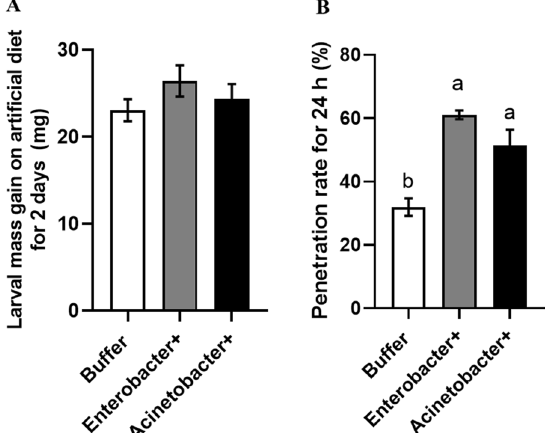
Fig. 6 Impacts of bacterial inoculation on the performance of SSB larvae. Axenically reared insects were inoculated with 2 bacterial isolates on artificial diet for 2 days and transferred to rice plants. A Growth of SSB larvae were analyzed when fed on artificial diet inoculated with Enterobacter and Acinetobacter ( F (2,100) 1.118, = P 0.3309; n 34–35). B The penetration rate of SSB larvae = = inoculated with Enterobacter and Acinetobacter within 3 days of feeding on rice plants were measured ( F (2, 6) 19.06, P 0.0025; = = n 3). Values are means SEM. Different letters above bars indicate = ± statistically significant differences between treatments based on an Fig. 7 Defensive responses of rice plants in response to oral ANOVA followed by LSD test ( P < 0.05). Buffer, SSB larvae inoculated secretion (OS) collected from Chilo suppressalis (SSB) larvae inoculated with 10 mM of MgCl 2 solution; Enterobacter , SSB larvae inoculated + with Enterobacter . (A) Rice stem samples were harvested 48 h with cells of Enterobacter ; Acinetobacter , SSB larvae inoculated with + after mechanical wounding with application of OS collected from Enterobacter inoculated SSB larvae (OS Enterobacter ) and OS + collected from axenic larvae (OS ), and the levels of defense-related − LOX enzymes were measured ( F (2,42) 20.43, P < 0.001, n 15). CK, = = untreated rice plants. B The 3rd instar larvae were allowed to feed on P 0.0025). In addition, both Enterobacter and Acineto- = rice plants pre-treated by mechanical wounding with application of bacter were detected in the damaged plant tissue infested OS Enterobacter and OS- for 3 days, and then larval mass gain was + with gnotobiotic larvae, while bacteria were not found 54.83, P < 0.001; n 38–40). CK, SSB larvae fed determined ( F (2,113) = = on plants damaged by axenic larvae inoculated with only on untreated rice plants. Values are means SEM. Different letters ± above bars indicate statistically significant differences between MgCl 2 solution (Additional file 1: Fig. S1). OS collected treatments based on an ANOVA followed by LSD test ( P < from SSB larvae inoculated with Enterobacter suppressed